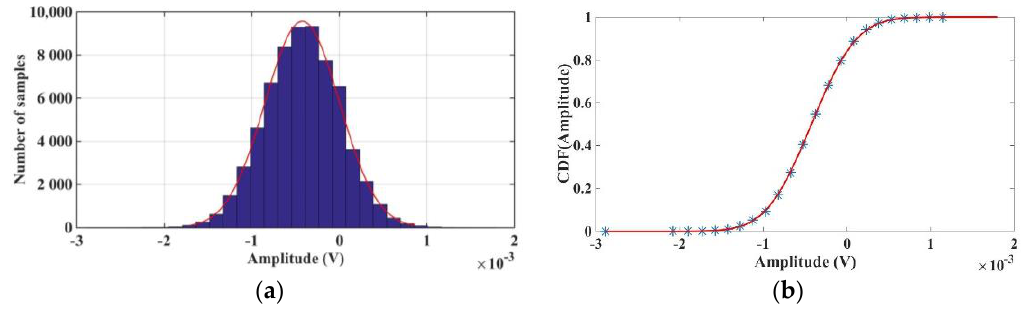
Figure 7. ( a ) Sample data distribution histogram with a normal fit; ( b ) Empirical Cumulative Distribution Function (CDF) (blue) and CDF of a normal distribution (red).